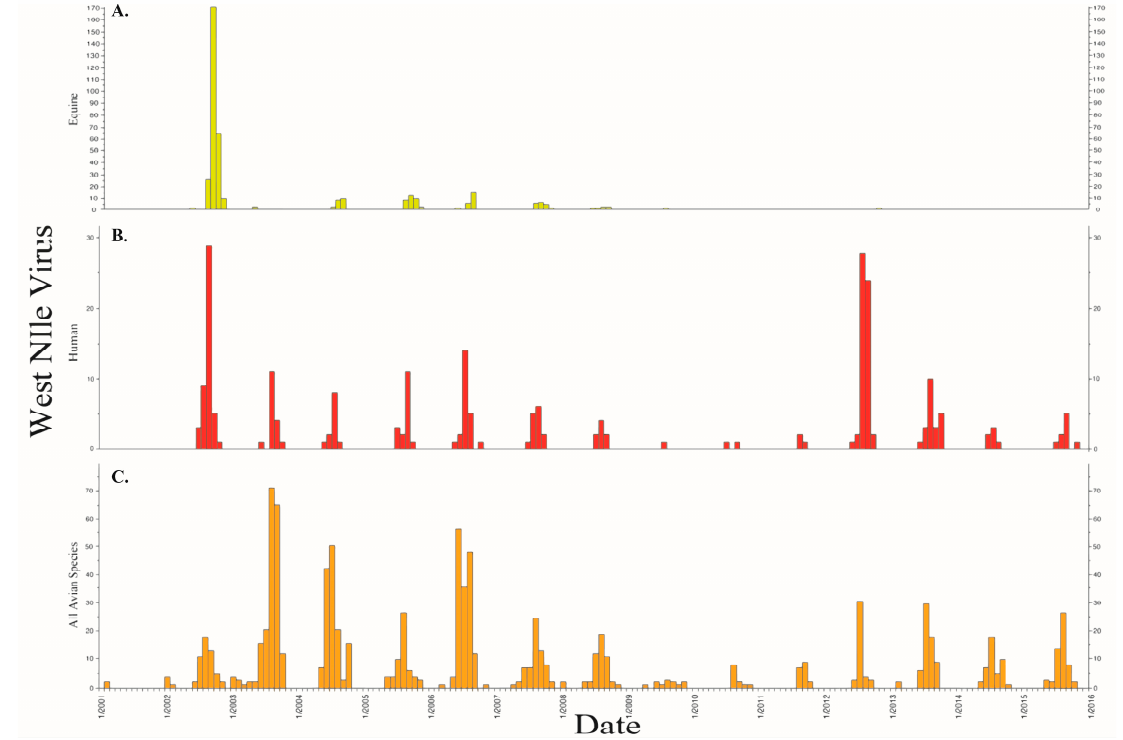
Figure 1. Confirmed Wisconsin WNV cases for equine ( A ), human ( B ), and all avian species ( C ) submitted by week, 2001–2016.